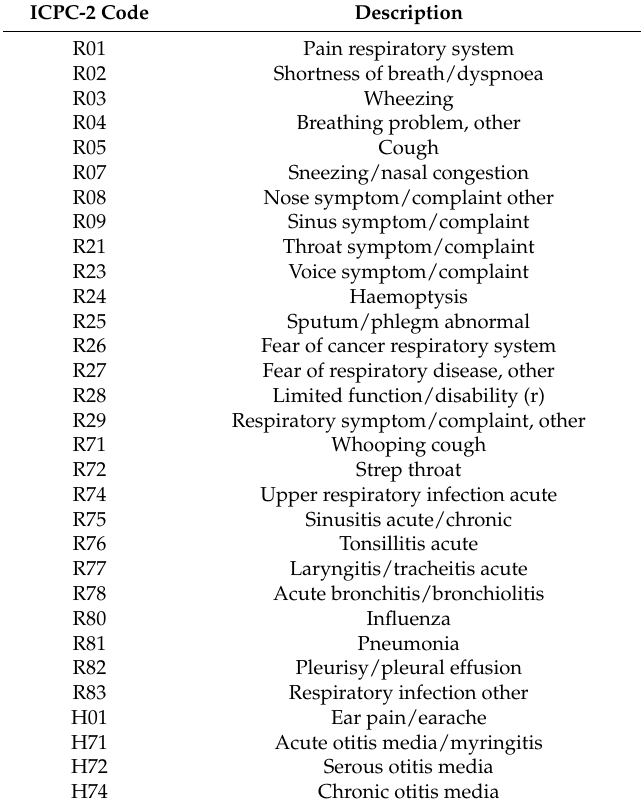
Table 4. International Classification of Primary Care 2 (ICPC-2) codes and corresponding descriptions.